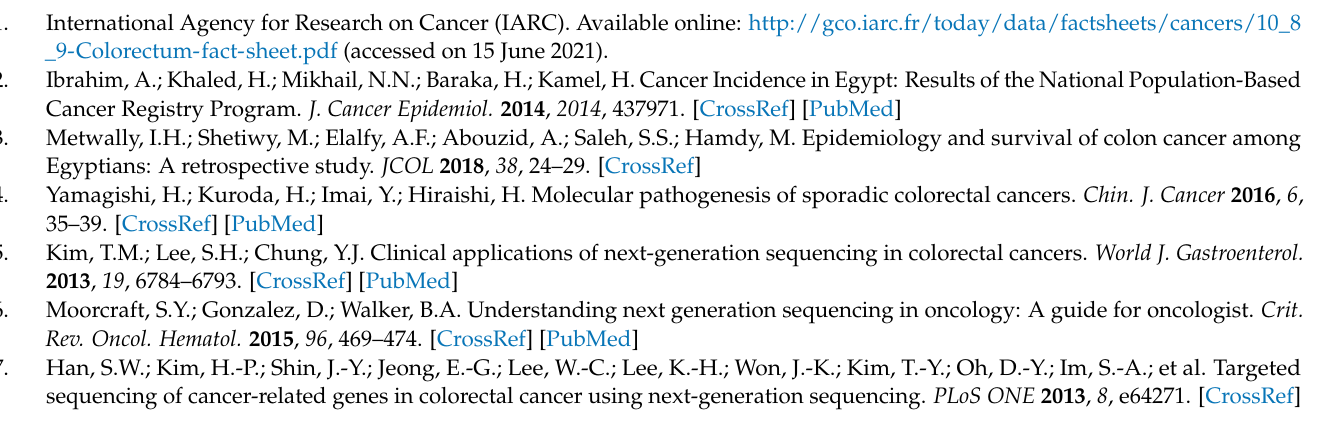
Table S1: Clinicopathological features of the studied groups, Table S2: The customized gene list. Table S3: The somatic mutations detected in the studied